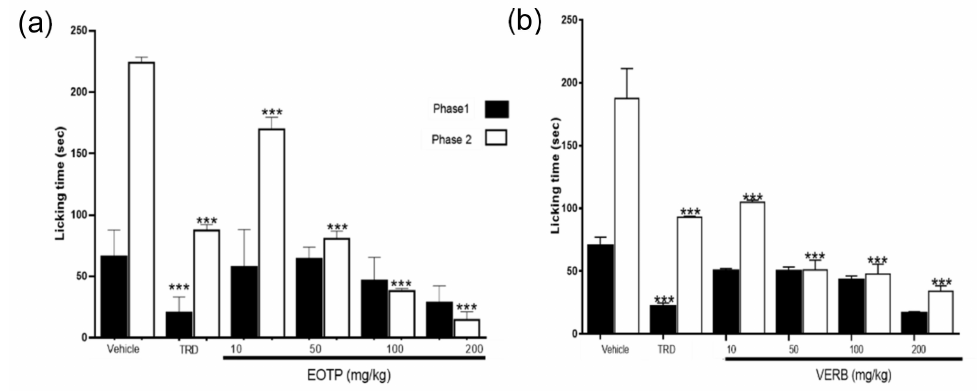
Figure 2. ( a ) The antinociceptive effects of EOTP in the formalin test at doses of 10, 50, 100, 200 mg/kg p.o. ( b ) The antinociceptive effects of VERB in the formalin test at different doses (10, 50, 100, 200 mg/kg p.o.) are shown in the formalin test’s two phases. TRD (10 mg/kg i.p.) was the negative control, whereas the vehicle was saline solution p.o. The figure shows the two phases of the formalin test. The experimental results were compared against the vehicle’s values expressed as the mean ± SEM. A significant difference (***) was determined at p <